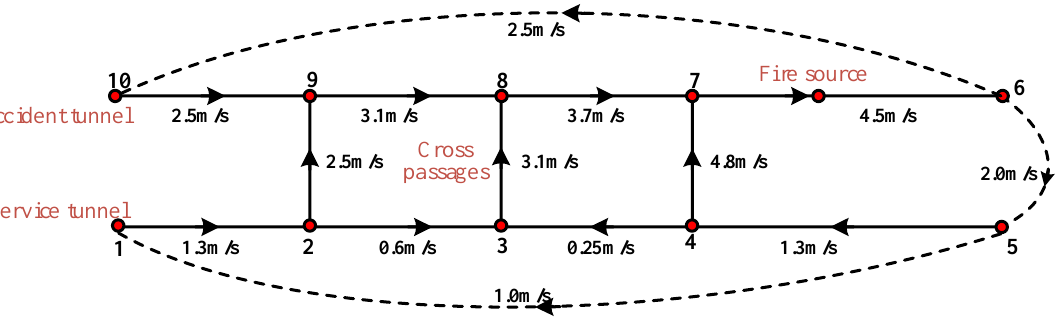
Figure 5. Calculation result of ventilation network.